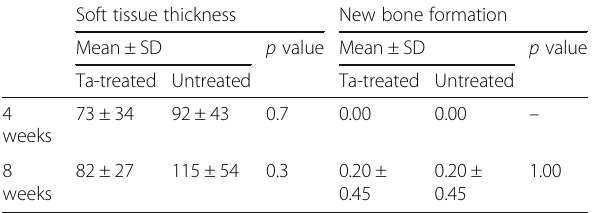
Table 2 Histological evaluation of silicone implants Soft tissue thickness New bone formation